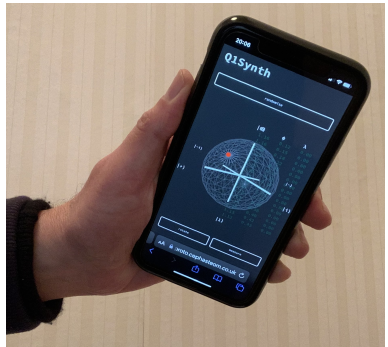
Figure 9. Towards a Quantum Internet of Things (QuIT): Q1Synth running on a smart